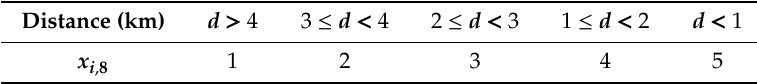
Table 8. Performance values x i ,8 for 8th criterion.